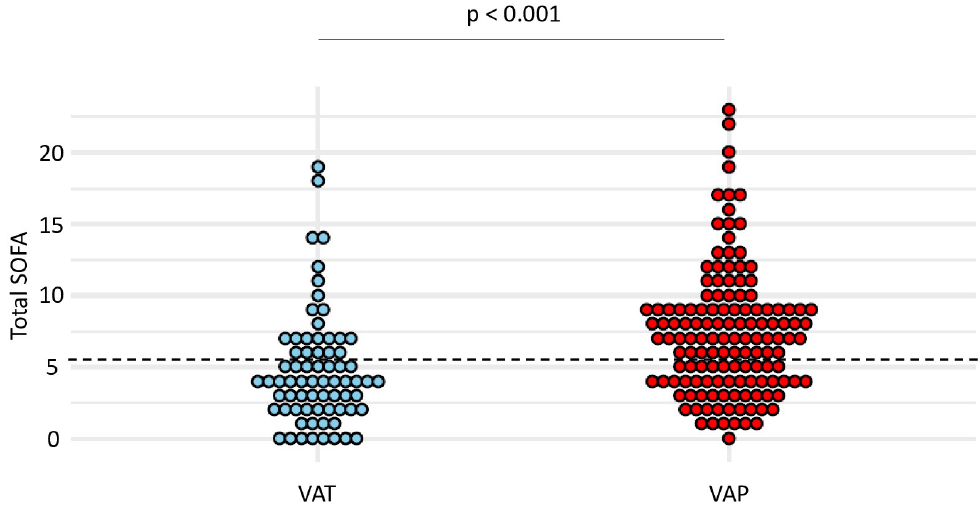
Fig 3. Dot plots of total SOFA in patients with VAT and VAP. Values of total SOFA, at VA-LRTI diagnosis, are shown as single dots for each patient. The dash line separates patients with a total SOFA � 6 from those with a total SOFA < 6, identified as the best cut-off according to the Youden index. SOFA sequential organ failure assessment; VAP ventilator- associated pneumonia; VAT ventilator-associated tracheobronchitis.